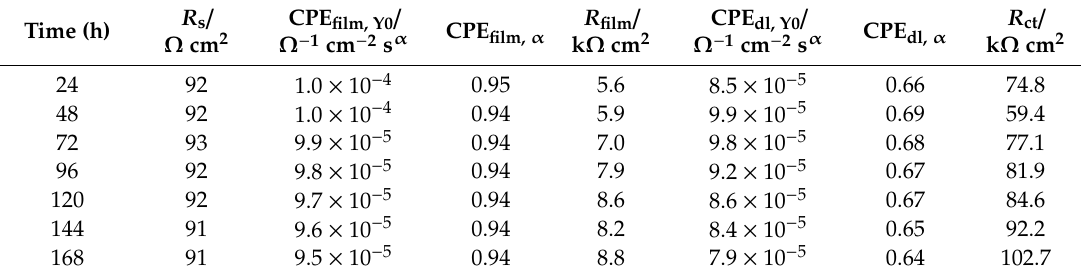
Table 2. Values of electric elements calculated for EEC of composite Ni